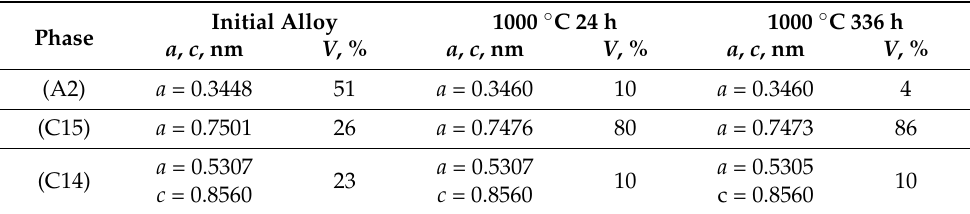
Figure 3. SEM images of the microstructure of the TiZrHfMoCrCo alloy annealed at 1000 °C: ( a ) 24 h and ( b ) 336 h. Table 2. Phases, lattice parameters a , c and the percentage of the phases V in the initial as-cast state of the TiZrHfMoCrCo alloy and after annealing at 1000 °C.